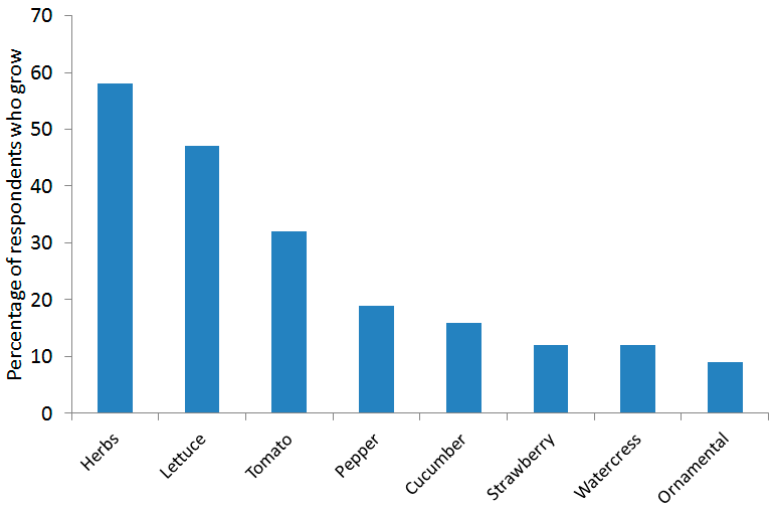
Figure 3. Percentage of all respondents that grew the eight most frequent vegetables. The total number of vegetables listed was 34. Herbs include basil, and lettuce includes salad greens.